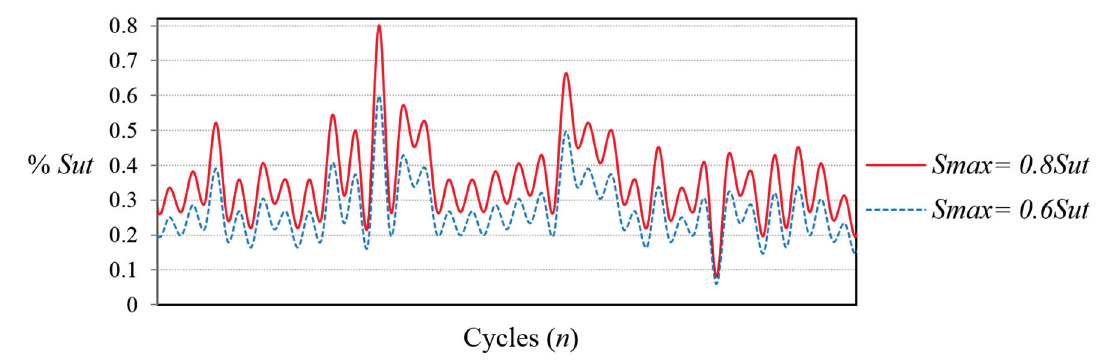
Figure 4. Fragment of the FALSTAFF load sequence with two different magnitudes of maximum peak